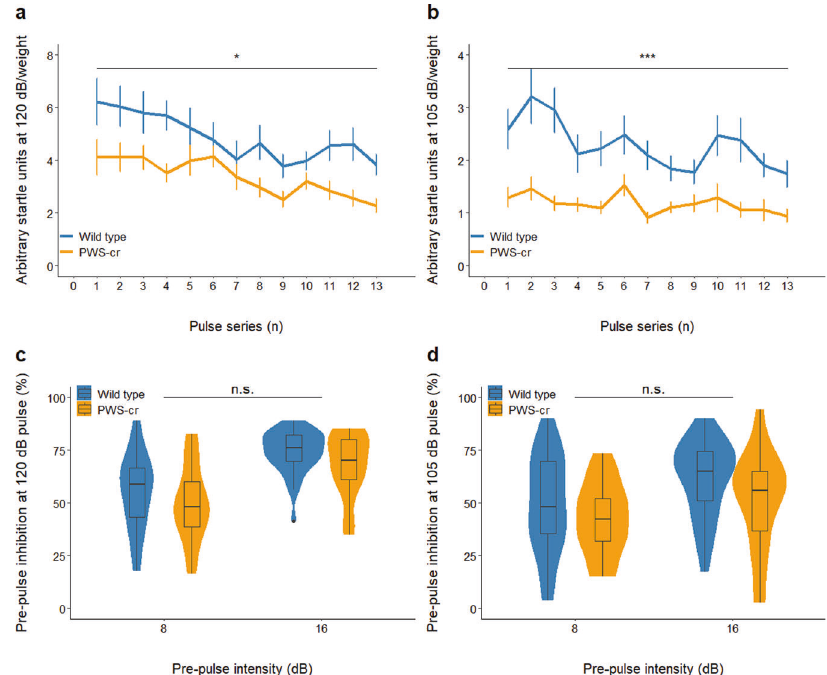
Fig. 2 Acoustic startle and pre-pulse inhibition. The startle response to a series of 13 acoustic stimuli at 120 dB ( a ) and 105 dB ( b ) was signi fi cantly reduced in PWS-cr mice ( n = 23) compared to their wild-type littermates ( n = 31) (* p < 0.05, *** p < 0.001). Pre-pulse inhibition of the acoustic startle response was measured by presenting noises of 8 dB and 16 dB 70 ms before the pulses of 120 dB ( c ) and 105 ( d ). The pre- pulse inhibition data showed operational sensory-motor gating, which was not affected by genotype (PWS-cr = 23, WT =